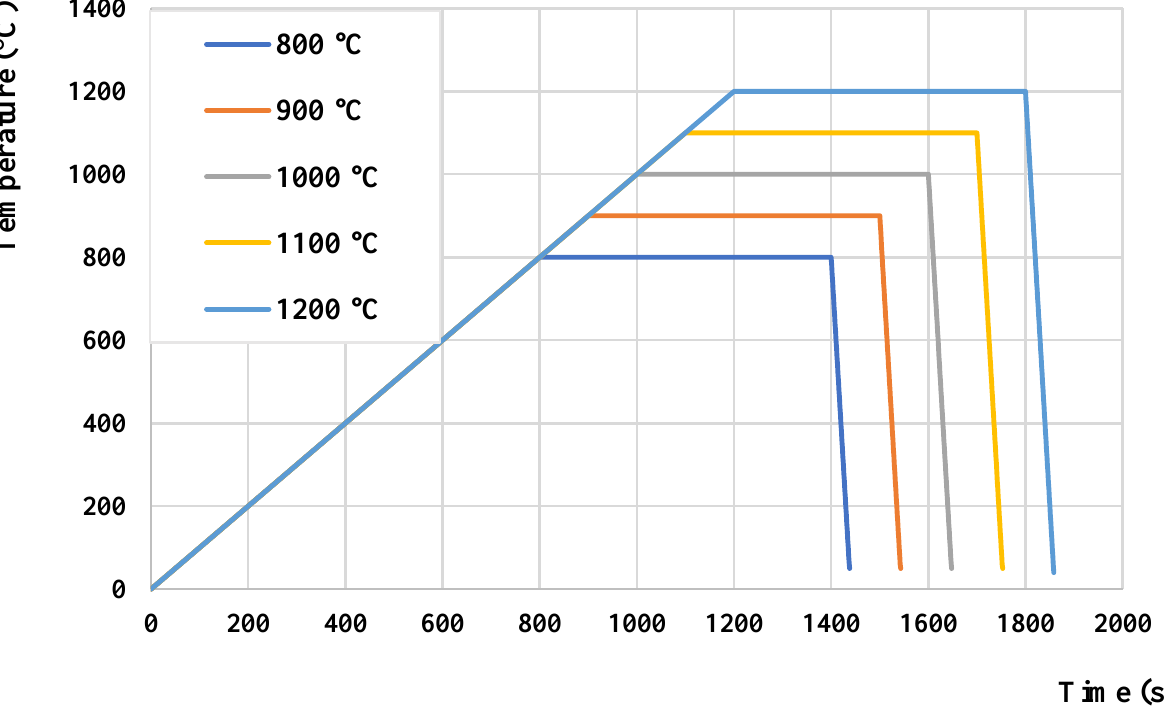
Figure 1. Thermal modes with a variation of austenitization temperature used for dilatometric analysis. Dilatometry was also used for the determination of phase transformations and con- struction of CCT and DCCT diagrams, whereby samples were tested using a Bähr